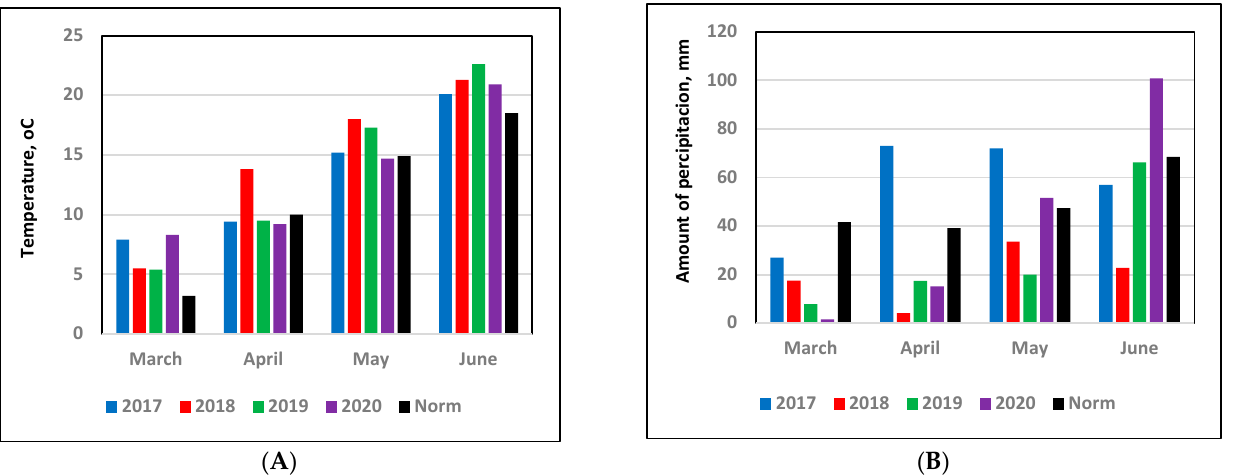
Figure 1. ( A ) Average monthly air temperature during the period of active vegetation, 2017–2020, and ( B ) average monthly precipitation during the period of active vegetation, 2017–2020. The following year, 2018, was extremely hot and dry. Through all the months,